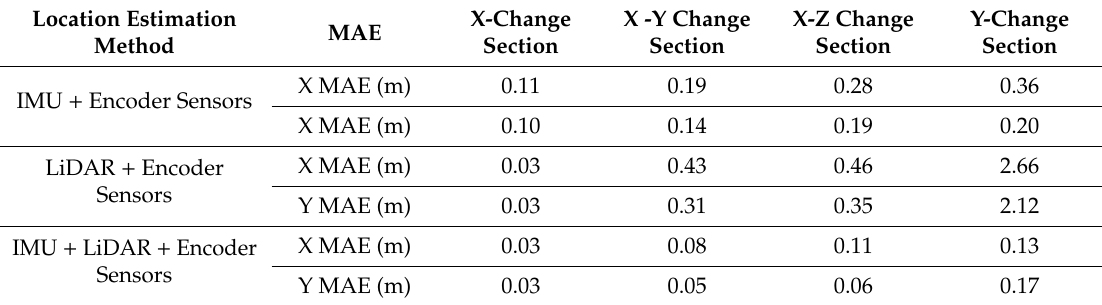
Table 2. Experiment results of the autonomous robot’s indoor location estimation at each section. Location